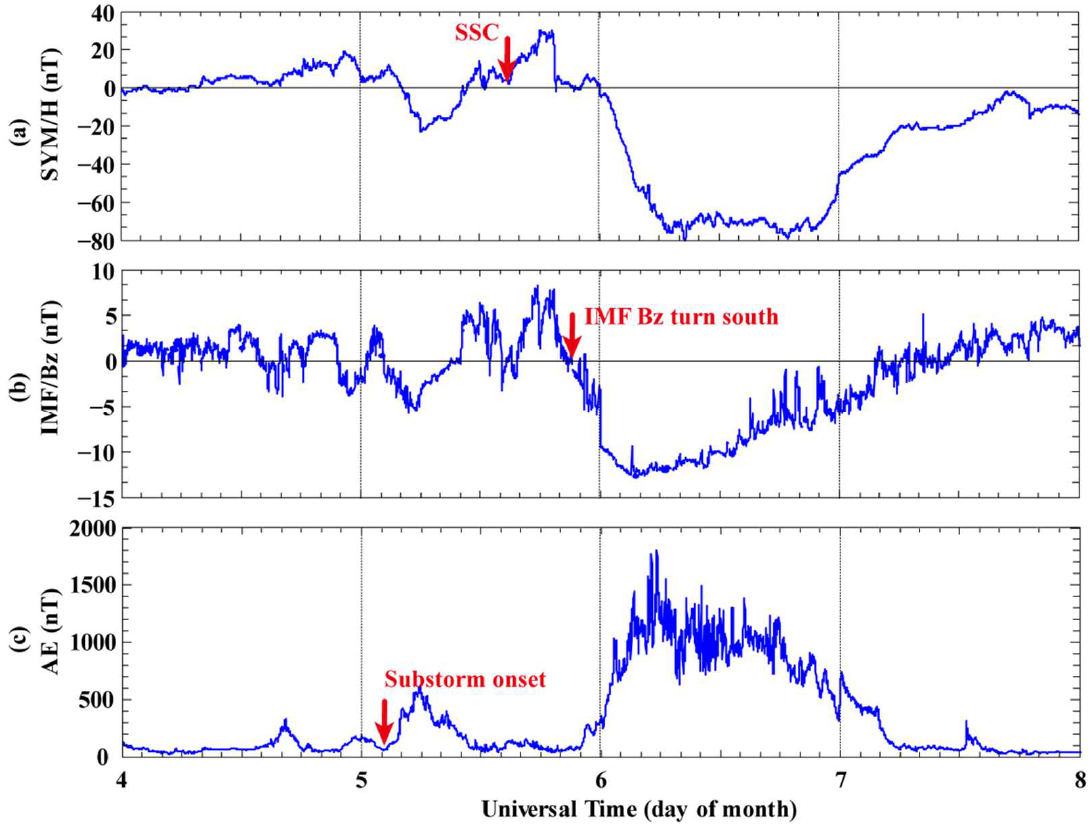
Figure 2. The variations of SYM/H index ( a ), IMF/Bz index ( b ), AE index ( c ) from 4 to 8 July 2013. Both the blanketing frequency (fbEs) and the critical frequency of Es layer are im- portant parameters for Es layers. However, as shown in Figure 3, the fbEs is not always recorded in ionograms when Es occurs. Thus, we focus on the variation of foEs in this study. Figure 4 demonstrates the observation of foEs at five stations, located at Eastern Asian sector. The red and green curves represent mean and median value of foEs, which are calculated by using the Es data from 30 June to 4 July during the geomagnetically undis- turbed period. After the IMF/Bz turning southward (~20:00 UT on 5 July), foEs observed at Yakutsk, Mohe, Jeju, Wuhan, and Hainan, enhanced from high latitude to low latitude in sequence. The beginning times of increases at the five stations were 20:30 on 5 July, 20:45 on 5 July, 23:45 on 5 July, 00:30 on 6 July, 01:00 on 6 July, respectively. Compared to the mean and median values of foEs, the enhancement of foEs resulting from the geomagnetic storm is 3–10 MH, and that of Hainan, located at lower latitude, is the smallest. It is noteworthy that only Yakutsk and Mohe, located at higher latitudes, in addition to the fore-mentioned enhancement, have another increase in foEs before the southern turning of IMF/Bz. This enhancement may relate to the substorm, which began at 00:00 UT on 5